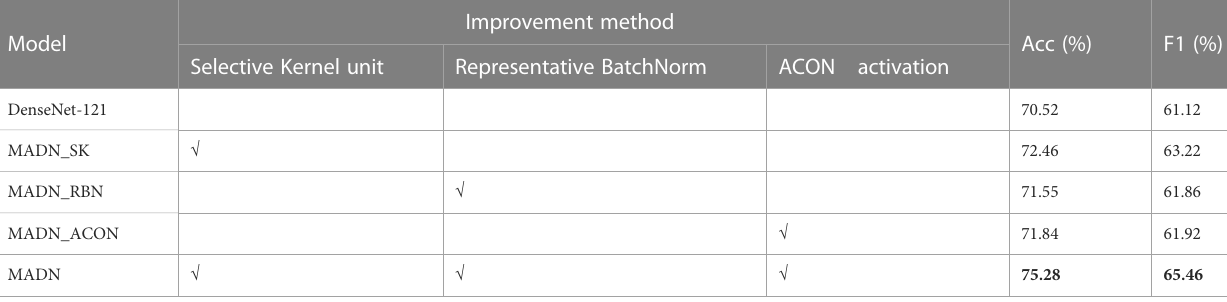
TABLE 4 Results of ablation experiments on the HQIP102 test